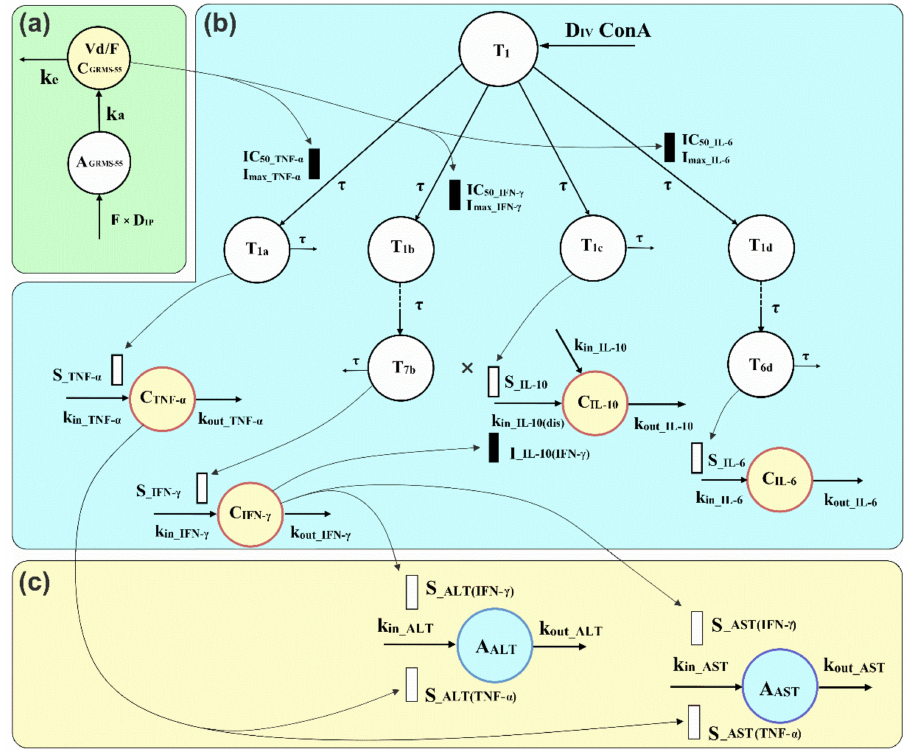
Figure 1. Schematic representation of the proposed PK/PD/disease progression model to describe the changes in the concentrations of TNF- α , IFN- γ , IL-6, and IL-10 (C TNF- α , C IFN- γ , C IL-6 , and C IL-10 ) and activities of ALT and AST (A ALT and A AST ) in the serum of female BALB/c mice pretreated IP with GRMS-55 at two dose levels or vehicle alone and subsequently challenged with ConA. The model is composed of ( a ) pharmacokinetic, ( b ) pharmacodynamic, and ( c ) disease progression parts; T 1 is the amount of a hypothetical precursor of production of inflammatory mediators; T 1a , T 1b –T 7b , T 1c , and T 1d -T 6d are quantities of hypothetical precursors of TNF- α , IFN- γ , IL-10, and IL-6, respectively, participating in the synthesis and/or release of these inflammatory mediators; I max _ TNF- α , I max _ IFN- γ , and I max _ IL-6 are the maximal inhibitory capacities of GRMS-55 on the production of mediators; C GRMS-55 is the concentration of the test compound in the serum, A GRMS-55 is its amount at the site of absorption, and F is the bioavailability of GRMS-55 following IP administration, Vd/F is the apparent volume of distribution of the test compound following IP dosing, k a and k e are the first-order rate constants of absorption and elimination of the studied compound, respectively; IC 50 _ TNF- α , IC 50 _ IFN- γ , and IC 50 _ IL-6 are the concentrations of GRMS-55 producing 50% of the maximal inhibition of each mediator production, τ is the mean transit and disappearance from the system time of precursors of inflammatory mediators; k in _ TNF- α , k in _ IFN- γ , k in _ IL-6 , k in _ IL-10 , k in _ ALT , and k in _ AST are the zero-order rate constants of production of each biomarker; k in _ IL-10(dis) is the zero-order production rate constant of IL-10 at the disease state; k out_TNF- α , k out_IFN- γ , k out_IL-6 , k out_IL-10 , k out_ALT , and k out_AST are the first-order rate constants of each biomarker loss; S_ TNF- α , S _IFN- γ , S _IL-6 , and S _IL-10 are, specific for each mediator, stimulation coefficients accounting for the amplification of the production of inflammatory mediators in response to ConA challenge; S _ALT(IFN- γ ) and S _ALT(TNF- α ) are stimulation coefficients describing the increase in ALT activity in the serum induced by IFN- γ and TNF- α , while S _AST(IFN- γ ) and S _AST(TNF- α ) are the stimulation coefficients accounting for amplification of AST release induced by IFN- γ and TNF- α ; I_ IL-10(IFN- γ ) is the linear inhibitory coefficient accounting for the inhibition of IL-10 production by IFN- γ